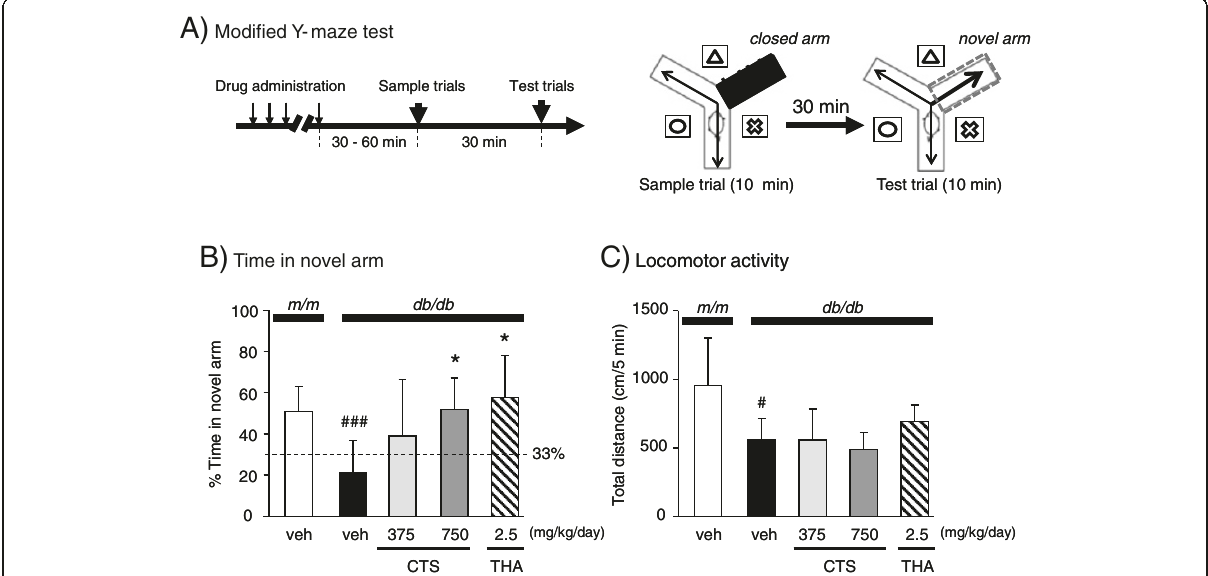
Figure 3 Diabetes-induced spatial working memory deficit in the MYM test and its reversal by test drugs. A ) Schematic drawings of the Y-maze and the experimental procedure. The maze was surrounded by different spatial cues. A ) Experimental protocol of the MYM test. The sample trial and test trials were conducted for 5 min at a 30-min interval. ( B ) Each test was conducted 30 min (THA) or 60 min after daily oral (CTS) or i.p. (THA) administration of test drugs. % Time spent in a novel arm (B) and total locomotion distance during a 5-min observation period were analyzed. Each data column represents the mean ± S.D. (n = 6 – 9). # P < 0.05 and ### P < 0.001 compared with vehicle-treated